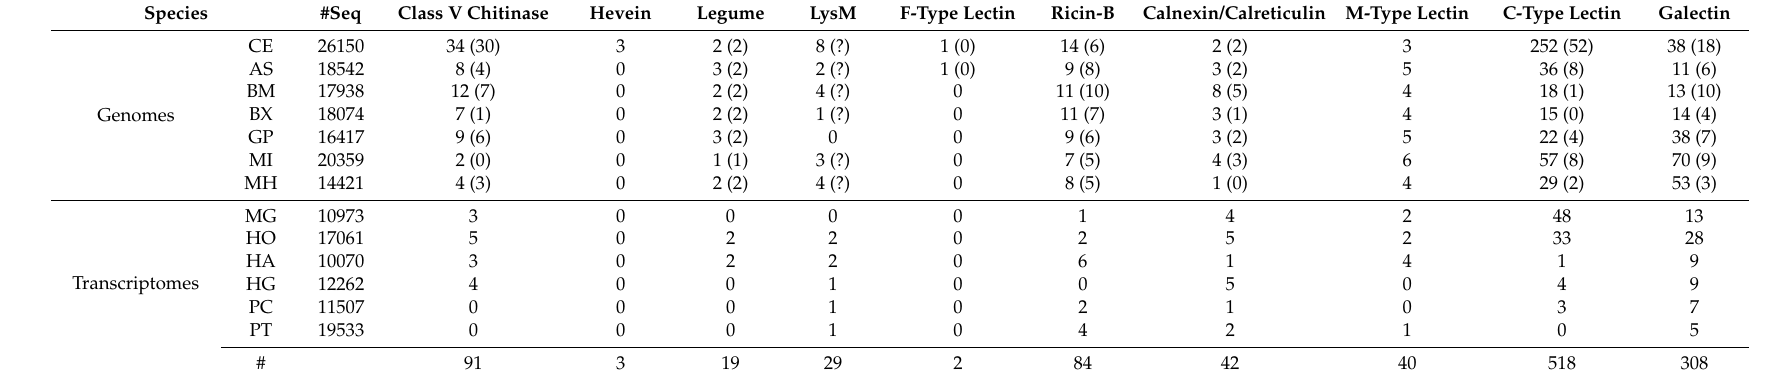
Table 1. Results of the profile hidden Markov model (HMMer) search. Numbers indicate the number of sequences with one or more domains of a type of lectin domain in each nematode species. The total number of sequences per lectin domain is indicated in the bottom row. Numbers in brackets give an indication of the number of potential carbohydrate-binding lectins, a question mark (?) indicates that we are unable to draw conclusions regarding carbohydrate binding properties. CE: Caenorhabditis elegans , AS: Ascaris suum , BM: Brugia malayi , BX: Bursaphelenchus xylophilus , GP: Globodera pallida , HA: Heterodera avenae